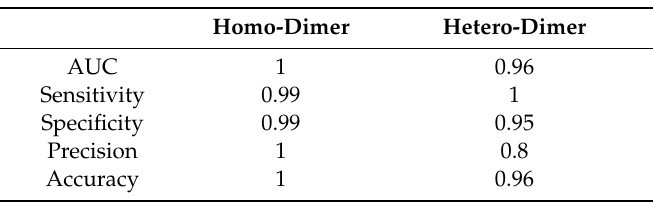
Table 2. Performance of SAAMBE-3D-DN in predicting disruptive and non-disruptive mutations for both homo- and hetero-dimers.